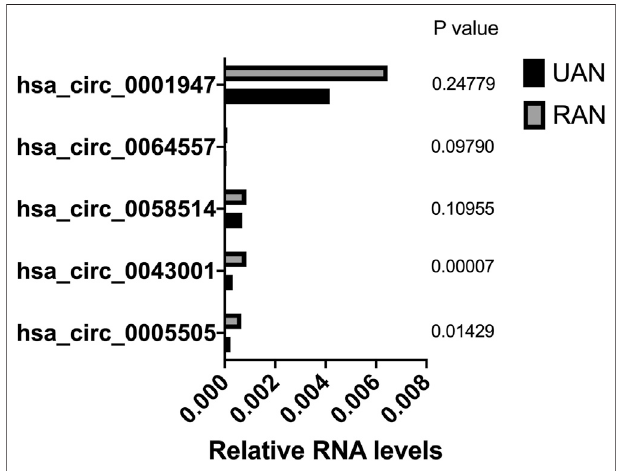
FIGURE 4 | Validation of the differential expression of fi ve upregulated circRNAs.